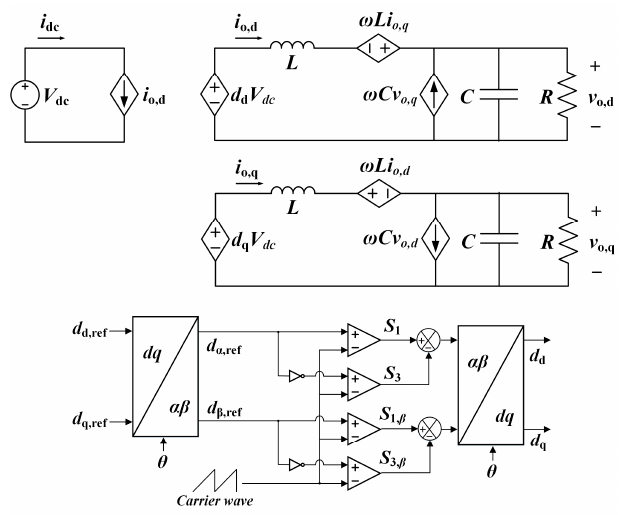
Figure 5. Equivalent plant model of single-phase full-bridge inverter considering unipolar SPWM in synchronous rotating frame.